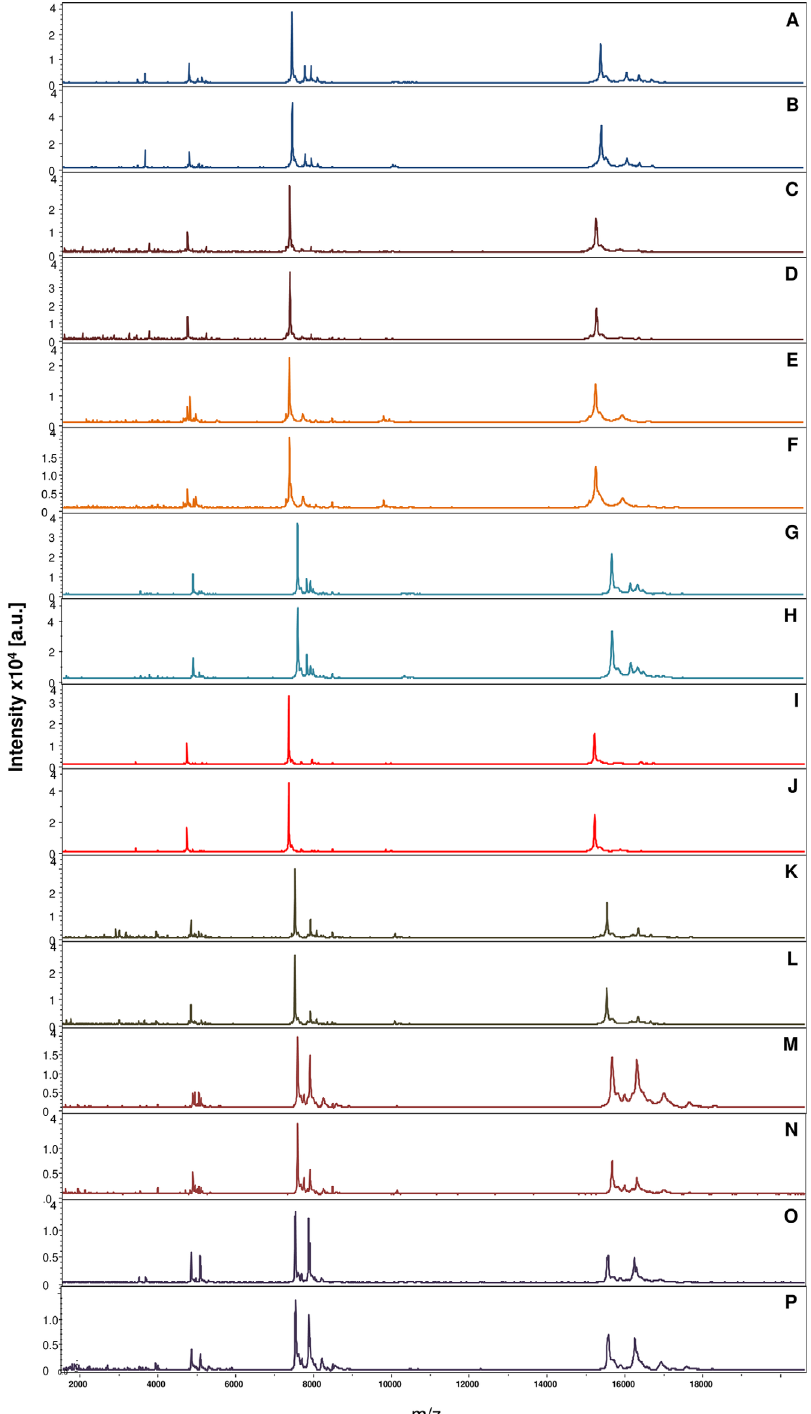
Figure 2. MALDI-TOF MS spectra of Anopheles gambiae Giles and Anopheles coluzzii abdomen protein extracts engorged on host blood vertebrates. All mosquitoes were collected only at times 1 and 24 h post-feeding. Alignment of MS spectra from: H1_ An_coluzzii _ Camelus dromedarius (A), H24_ An_coluzzii _ Camelus dromedarius (B), H1_ An_coluzzii Ammotragus lervia (C), H24_ An_coluzzii Ammotragus lervia (D), H1_ An_coluzzii _ Sus scrofa (E), H24_ An_coluzzii _ Sus scrofa (F), H1_ An_gambiae _ Papio hamadryas (G), H24_ An_gambiae _ Papio hamadryas (H), H1_ An_gambiae _ Antidorcas marsupialus (I), H24_ An_gambiae _ Antidorcas marsupialus (J), H1_ An_gam- biae _ Arctictis binturong (K), H24_ An_gambiae _ Arctictis binturong (L), H1_ An_gambiae _ _ Panthera onca (M), H24_ An_gambiae _ _ Panthera onca (N), H1_ An_gambiae _ Leopardus pardalis (O), and H24_ An_gambiae _ Leopardus pardalis (P). a.u. arbitrary units; m / z mass-to-charge